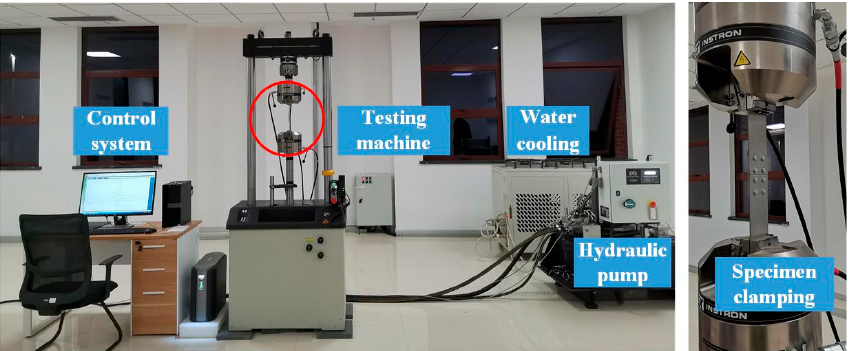
Figure 20. The fatigue tests using INSTRON 8801 fatigue testing machine.